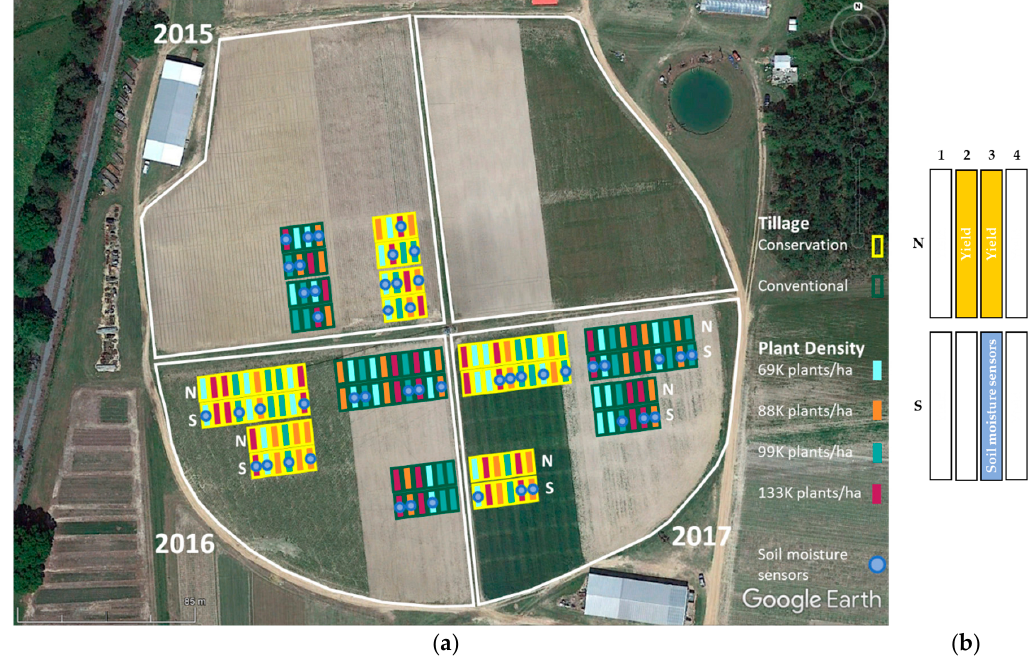
Figure 2. ( a ) Plot plans of maize during 2015, 2016, and 2017 growing seasons in RDC field and ( b ) plots configuration.